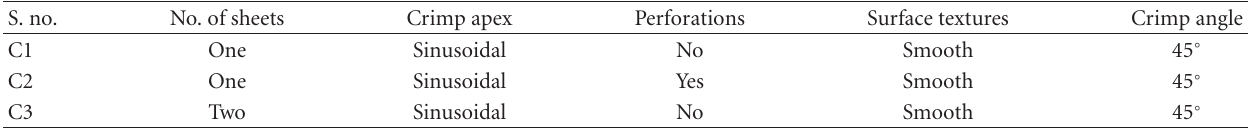
Figure 2: Di ff erent packings used in industrial applications: (a) smooth, perforated; (b) 3D grooved, perforated; (c) 3D embossed, unperforated. Table 1: Details of di ff erent geometries utilized in this